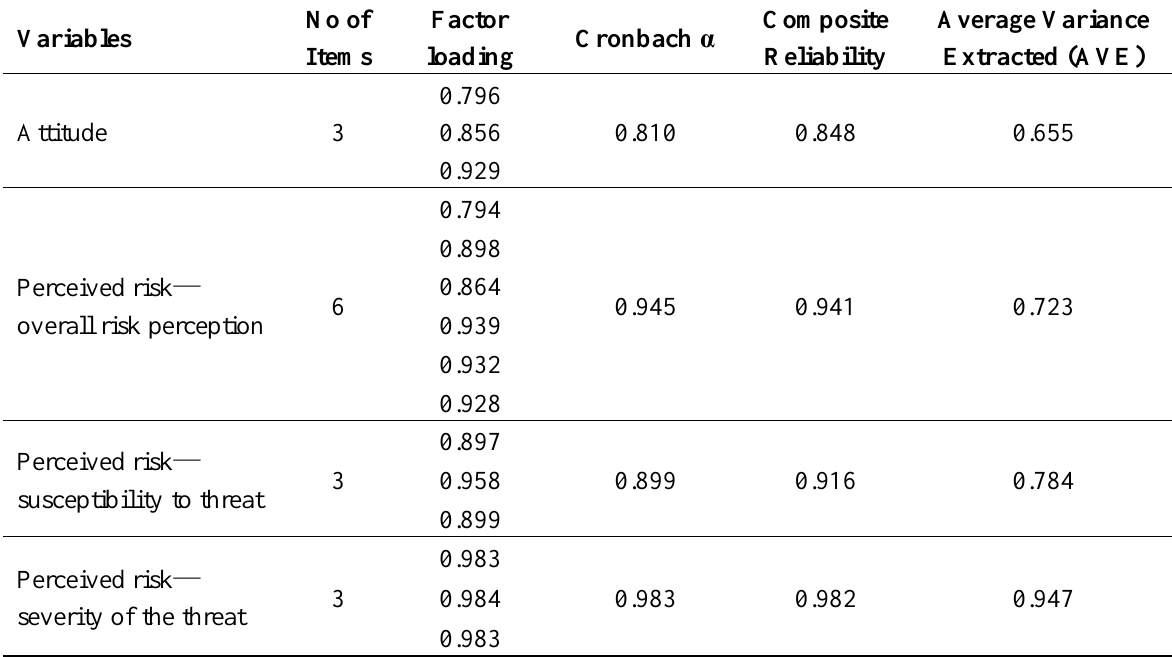
Table 4. Scale reliabilities and validity.